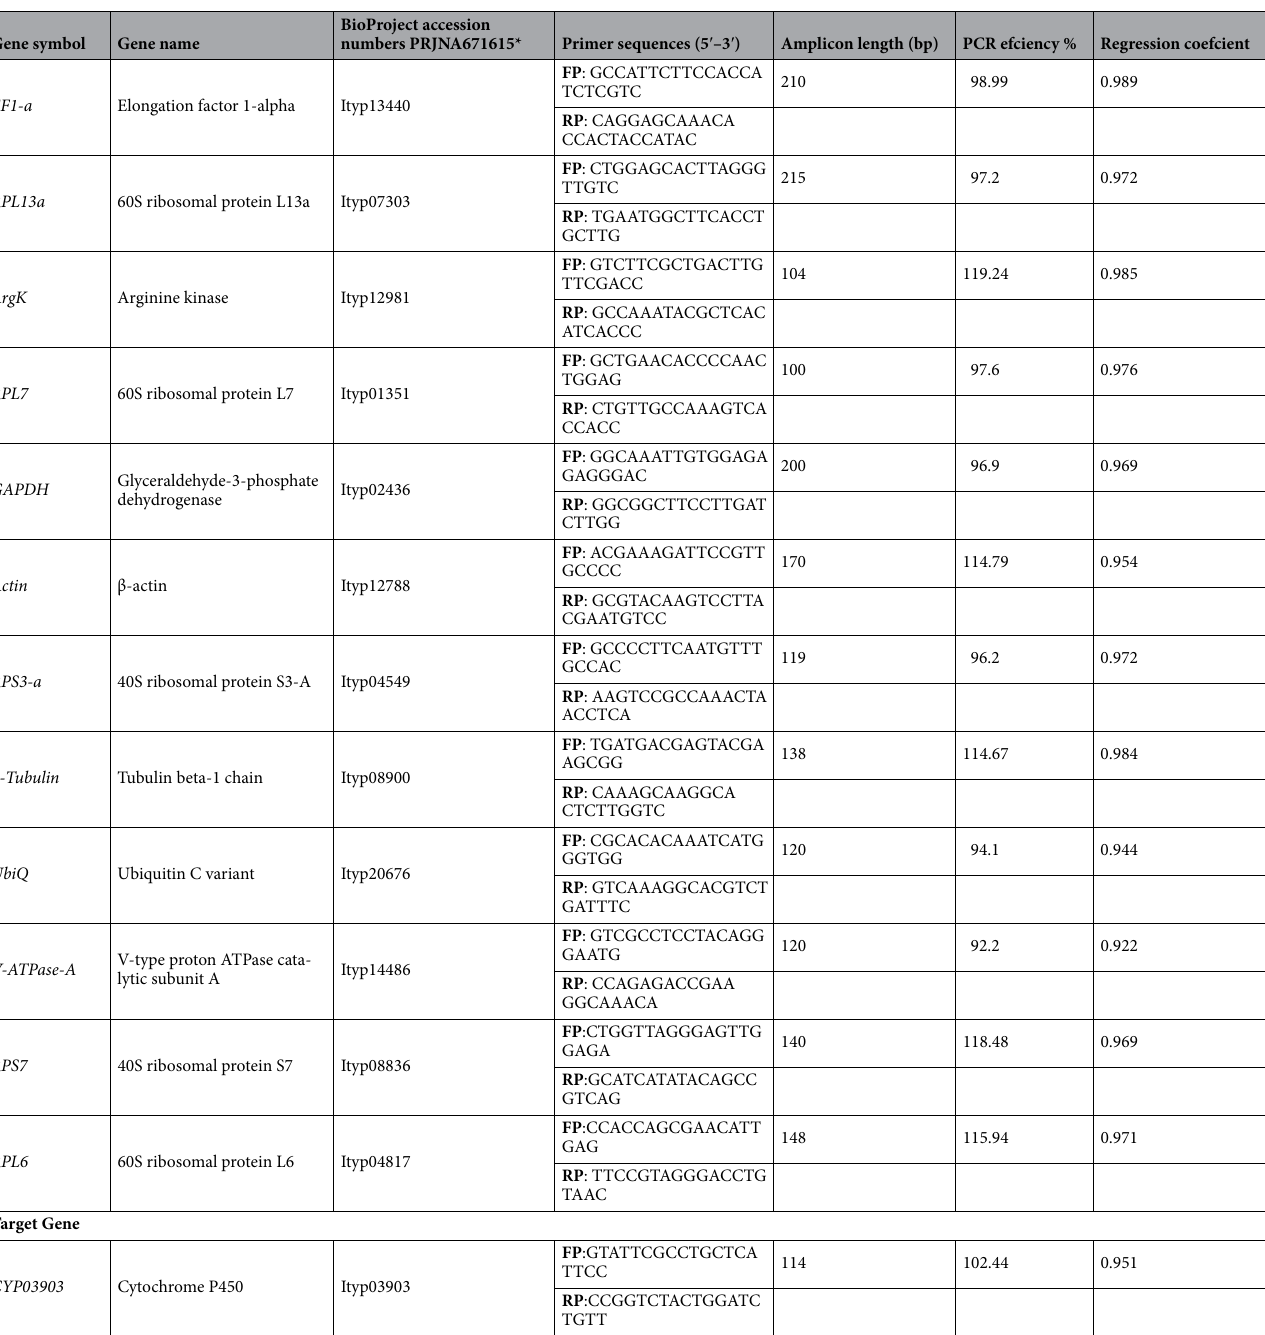
Table 2. Primer sequence, amplicon length and RT-qPCR analysis of candidate reference genes and a target gene. *Powell et al.